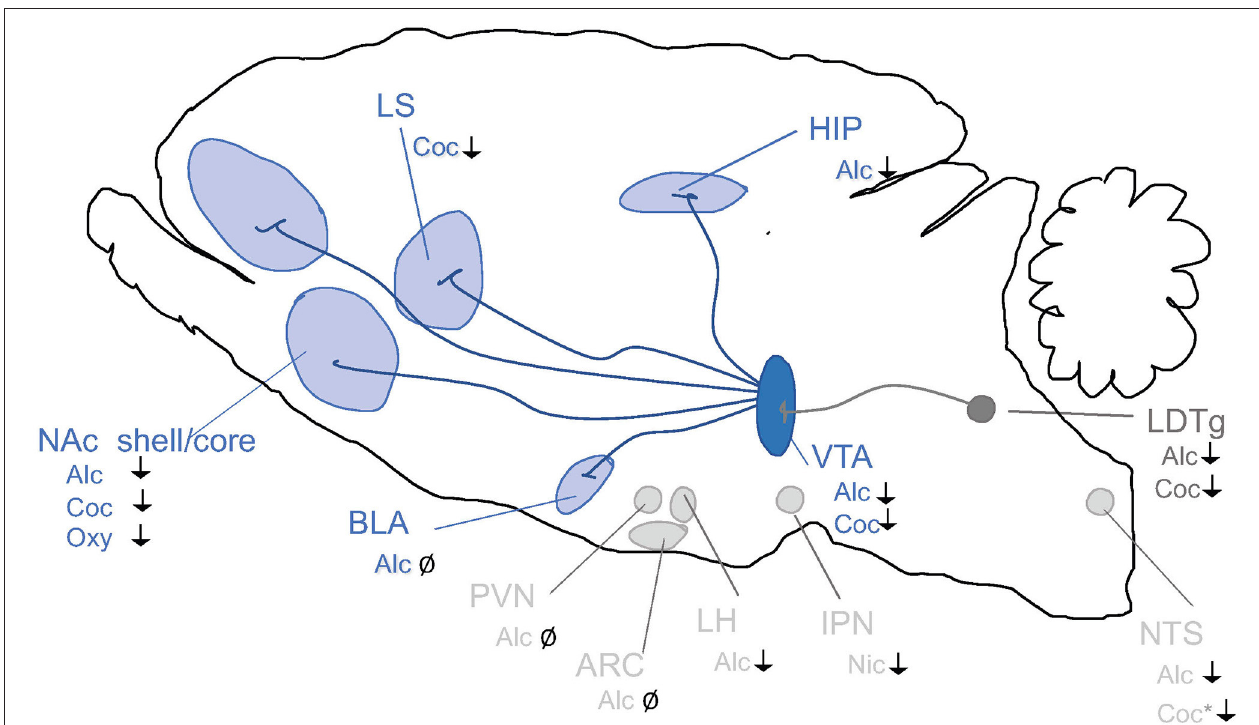
FIGURE 4 | Schematic illustrations of brain regions important for the interaction between the GLP-1 pathway and addiction processes. GLP-1R agonists attenuate behaviors relating to reward and intake of alcohol (Alc), nicotine (Nic), cocaine (Coc) and oxycodone (Oxy). Nucleus tractus solitarii (NTS) of the brain stem, ventral tegmental area (VTA), nucleus accumbens (NAc) shell, laterodorsal tegmental area (LDTg), basolateral amygdala (BLA), lateral septum (LS) and hippocampus (HIP), paraventricular nucleus (PVN), arcuate nucleus (ARC) and lateral hypothalamus (LH) and interpeduncular nucleus (IPN). ↓ Shows an attenuation and Ø reflects no change. *Role shown